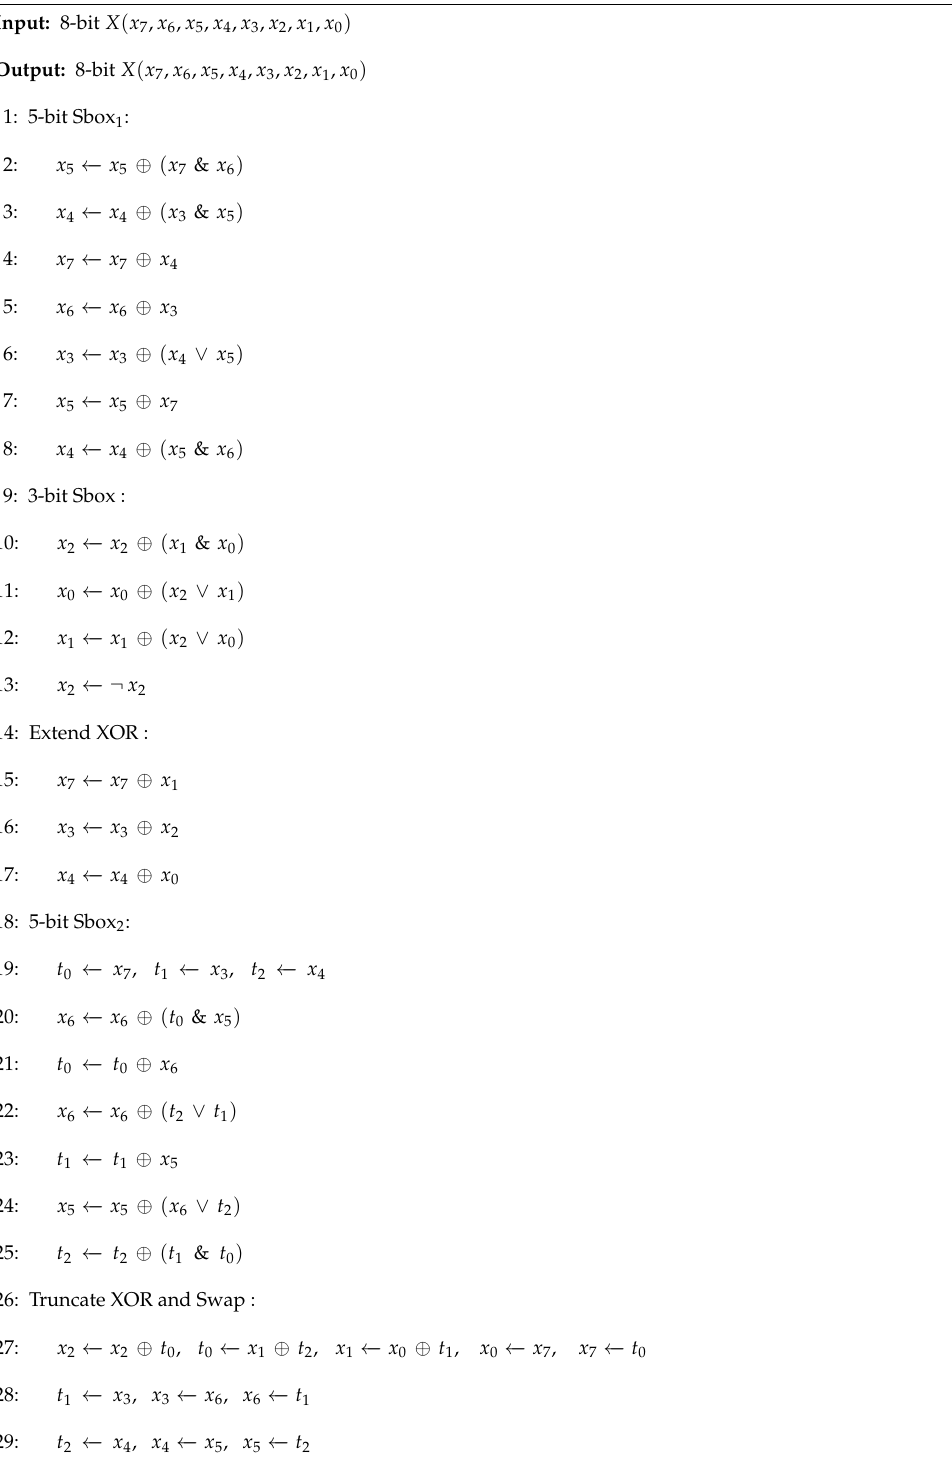
Algorithm 1 Bitslicing implementation of PIPO